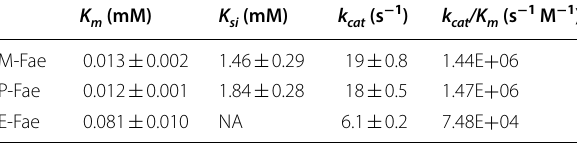
Table 2 Kinetic parameters of the Mt Fae1a versions on methyl p